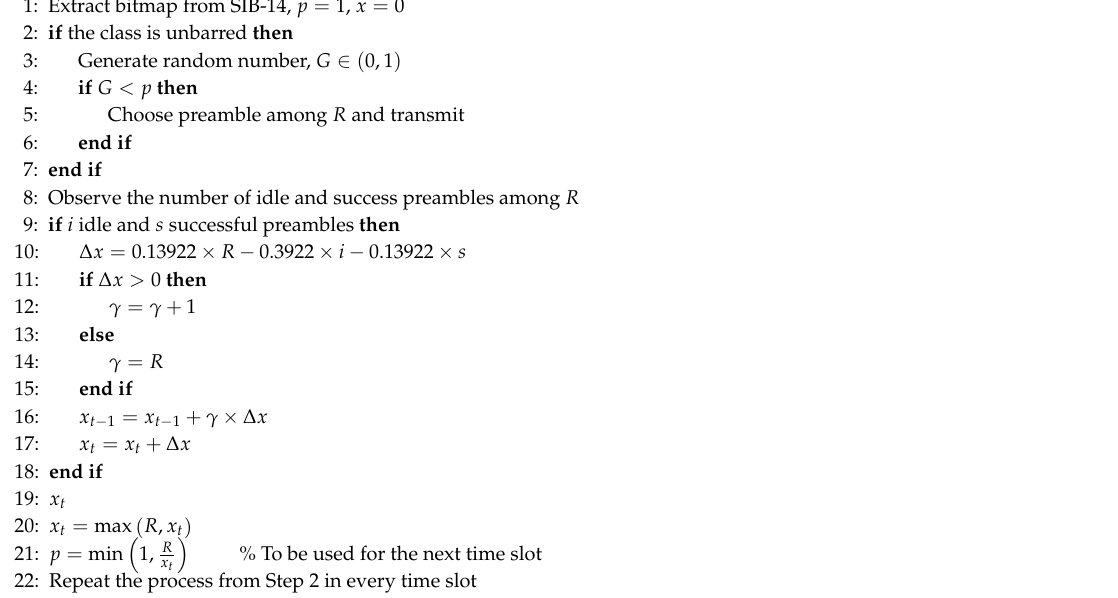
Algorithm 2 Combined Access Barring (CAB) Scheme using Bayesian